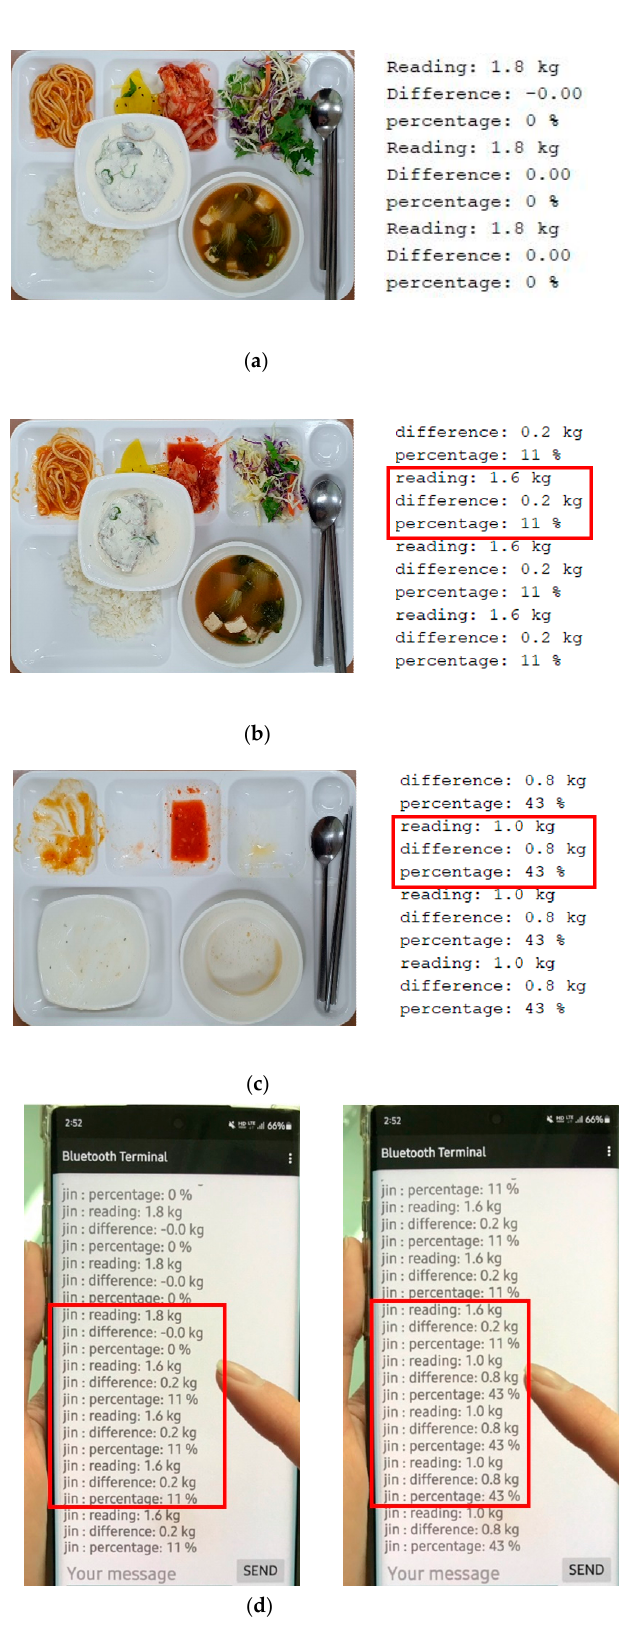
Figure 6. Meal-weight measurements with a corrected calibration factor: ( a ) initial meal, ( b ) meal in the middle, ( c ) after the meal time, and ( d ) wireless transfer via Bluetooth. Hence, nurses and families can see clearly in real time how much food the patient has eaten. In addition, all the acquired information can be continuously transferred wire- lessly to the mobile phones of nurses in charge and the patient’s family. The left picture in Figure 6d shows the screen of a mobile phone with the information of the weight var- iation through the process of meal intake. The relative difference of weight is also clearly shown. The right picture in Figure 6d corresponds to the case of Figure 6c.